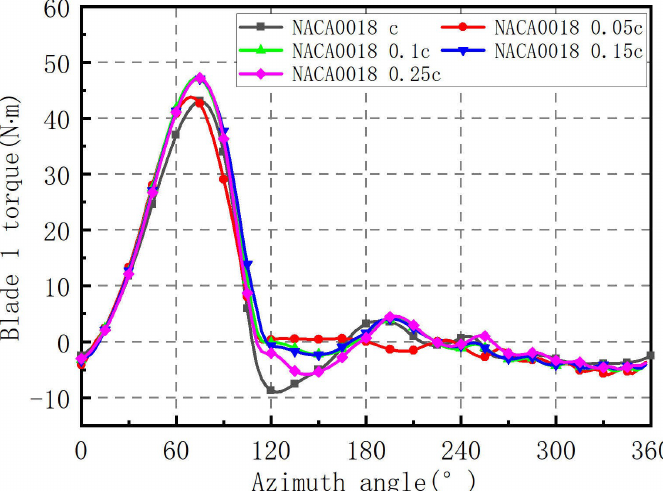
Figure 25. TSR = 1.5 instantaneous torque curve of J-shaped blade.